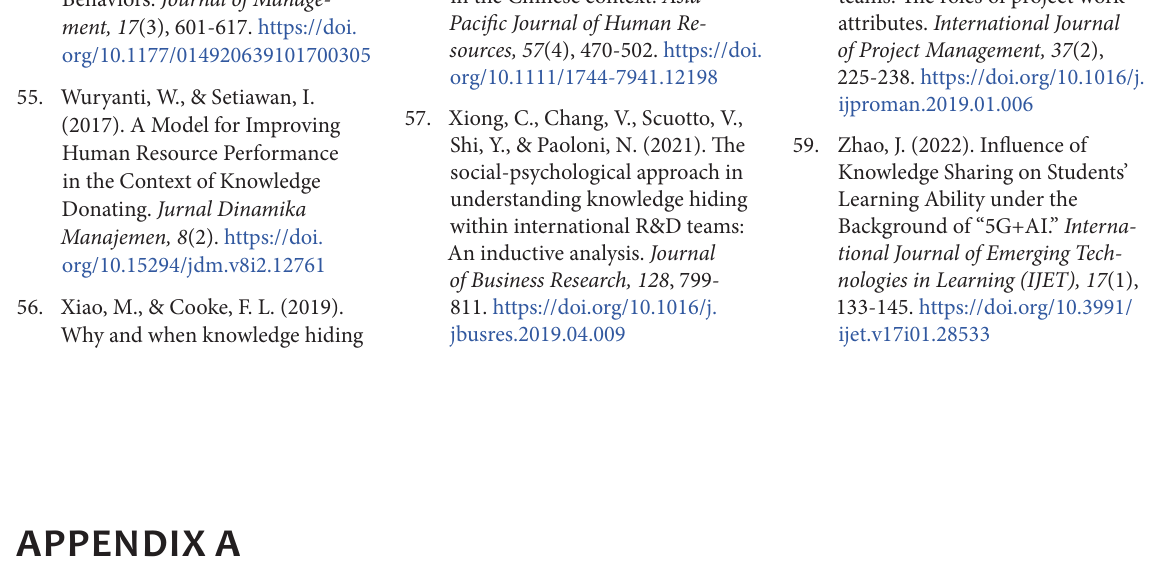
Table A1. Questionnaire Category Items Source